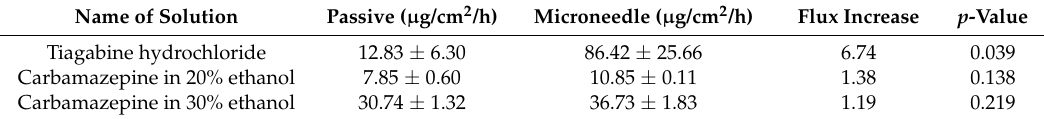
Table 2. Transdermal flux ( µ g/cm 2 /h ± SD) of tiagabine hydrochloride and carbamazepine in 20% and 30% ethanol following treatment with a 500 µ m microneedle roller. Passive flux values served as controls ( n =